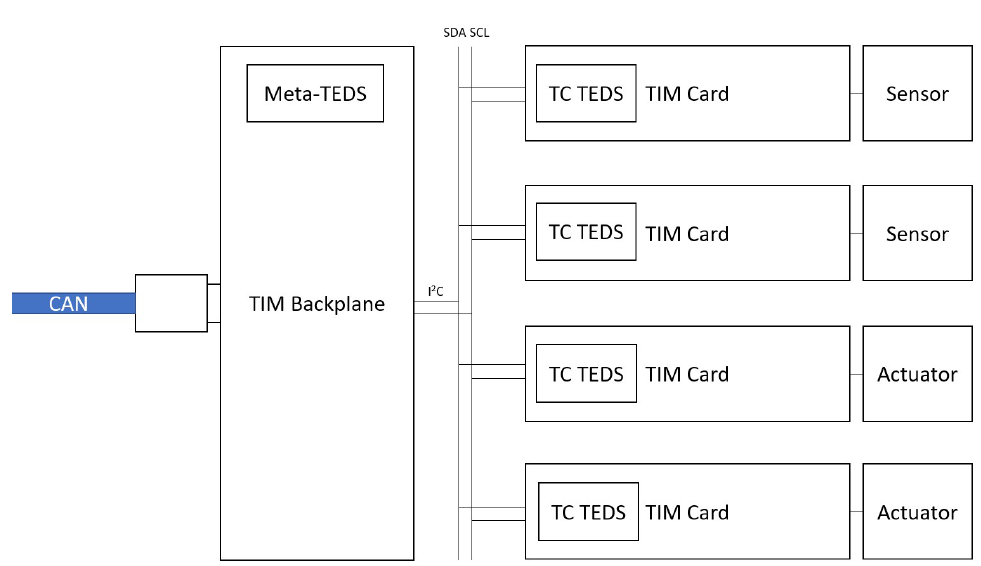
Figure 6. Graphical representation of an implementation of the presented architecture.